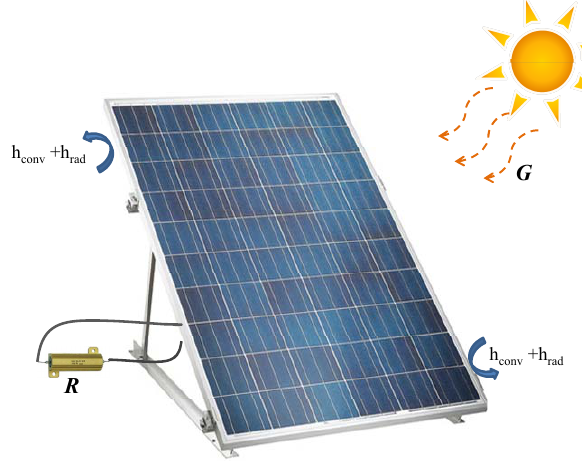
Figure 2. Sketch of energy exchanges of PV panel with surrounding